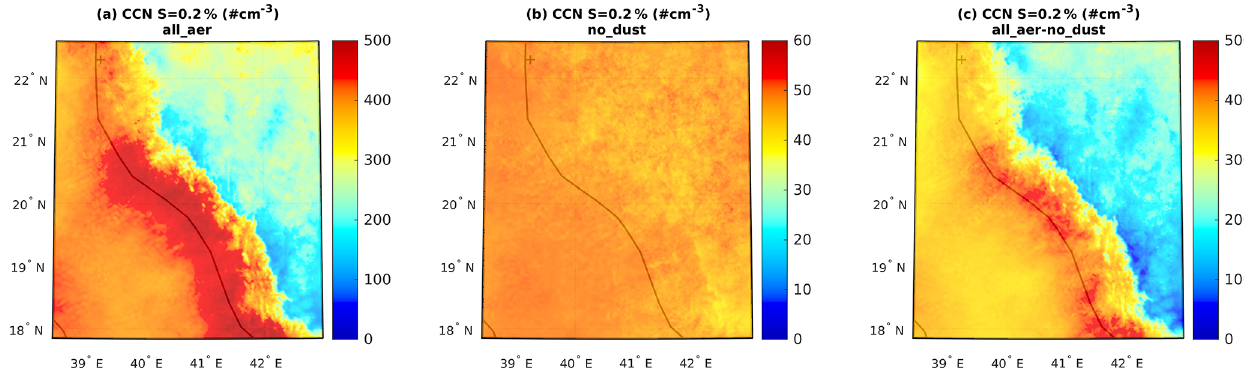
Figure 11. CCN number concentrations at 0.2% supersaturation at a cloud-level height (570hPa) averaged at 15:00UTC for 4–31 August (a) all_aer (F1), (b) no_dust (F2), and (c) the difference F1 − F2.